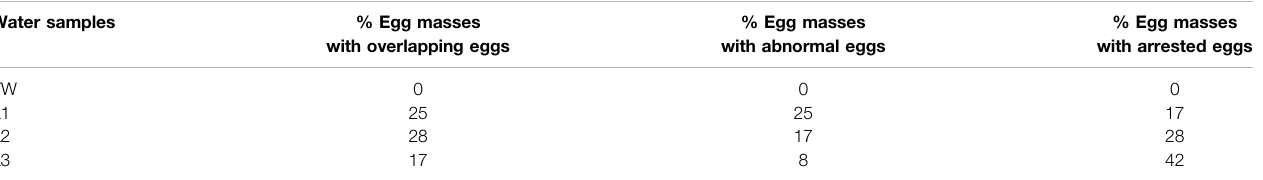
TABLE 4 | Percentages of Biomphalaria straminea egg masses with overlapping eggs, abnormal eggs and arrested eggs. TW: tap water; L1, L2, and L3: sites of sampling, Lugano Lake, Buenos Aires. Water samples